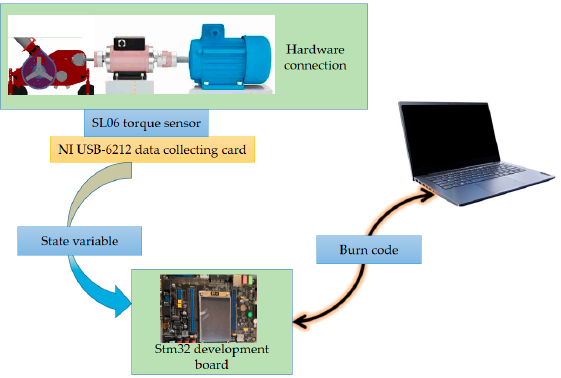
Figure 4. Schematic diagram of specific power consumption test system.